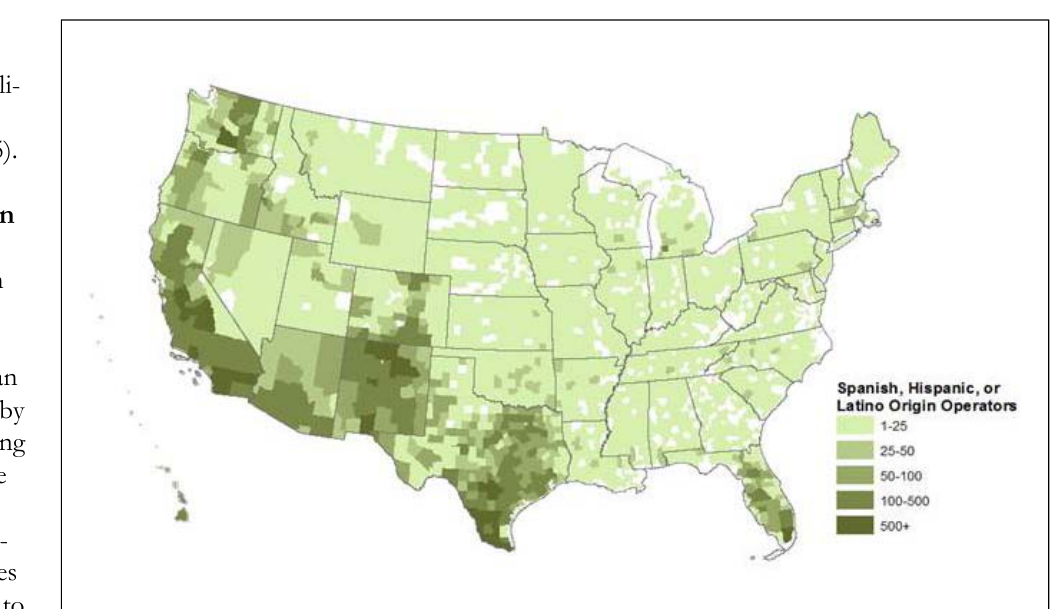
Figure 7. Spatial Distribution of Hispanic Farmers,